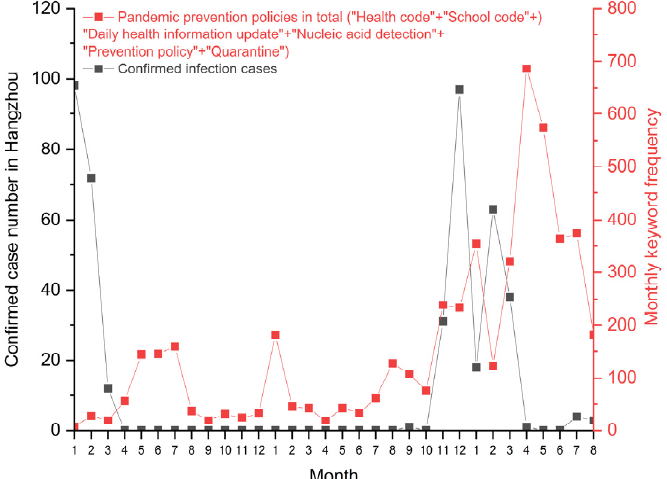
Figure 4. Monthly keyword frequency about epidemic prevention policies as compared with the number of confirmed infection cases in Hangzhou.